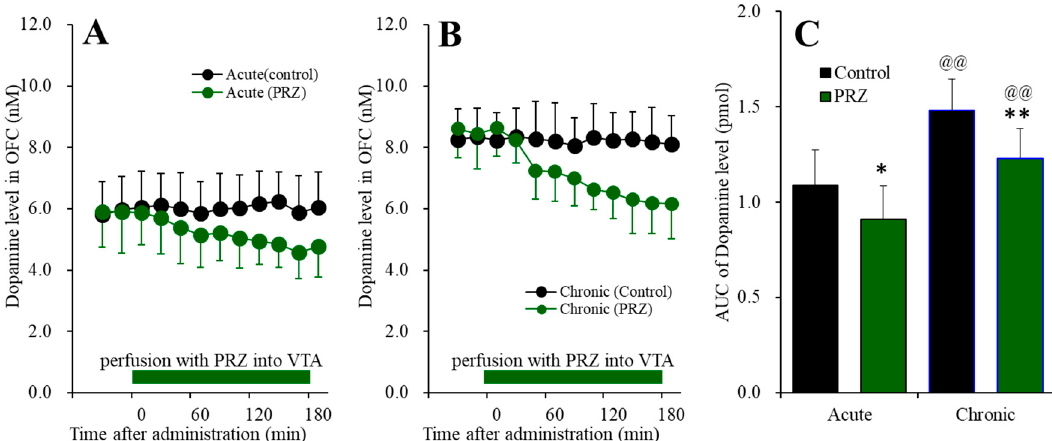
Figure 6. Effects of acutely local administration (perfusion with) 100 μ M prazosin (PRZ) into the VTA on extracellular dopamine level in the OFC, after the systemically chronic administration of guanfacine (0 or 0.12 mg/kg/day for 14 days). Panel ( A ) indicates the effects of perfusion with 100 μ M PRZ into the VTA after chronic administration of guanfacine (0 mg/kg/day) for 14 days (acute effects). Panel ( B ) indicates effects of 100 μ M PRZ after systemically chronic administration of guanfacine (0.12 mg/kg/day) for 14 days (chronic effects). Ordinates: mean ± SD (n = 6) of extracellular dopamine level (nM), abscissa: time after administration of perfusion with PRZ into the VTA (min). Green bars: perfusion of 100 μ M PRZ into VTA. Panel ( C ) indicates the AUC 20–180 min values of extracellular dopamine level during perfusion with PRZ (from 20 to 180 min). Ordinates: mean ± SD (n = 6) of AUC 20–180 min values of extracellular dopamine level (pmol). Black and green columns indicate respective control and perfusion of PRZ of AUC values of dopamine levels. When the effects of PRZ were statistically significant compared using MANOVA, the data were analysed using Tukey’s post hoc test. * p < 0.05, ** p < 0.01, compared with control. @@ p < 0.01: compared with acute effects of PRZ.